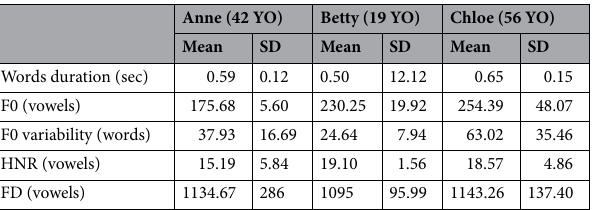
Table 2. Acoustical parameters of the stimuli presented in the task. F0 fundamental frequency, HNR harmonics to noise ratio, FD formant